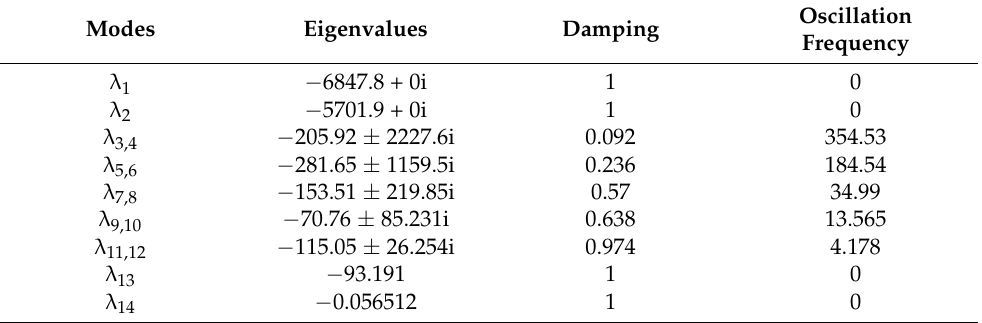
Table 4. Eigenvalues of the proposed control method.